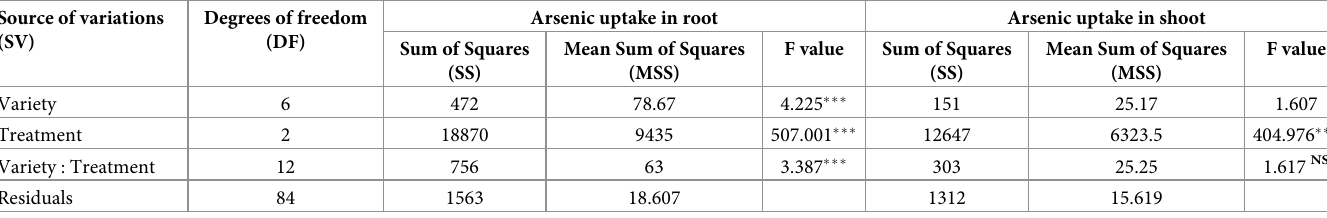
��� indicates significant difference at p < 0 . 001 level of